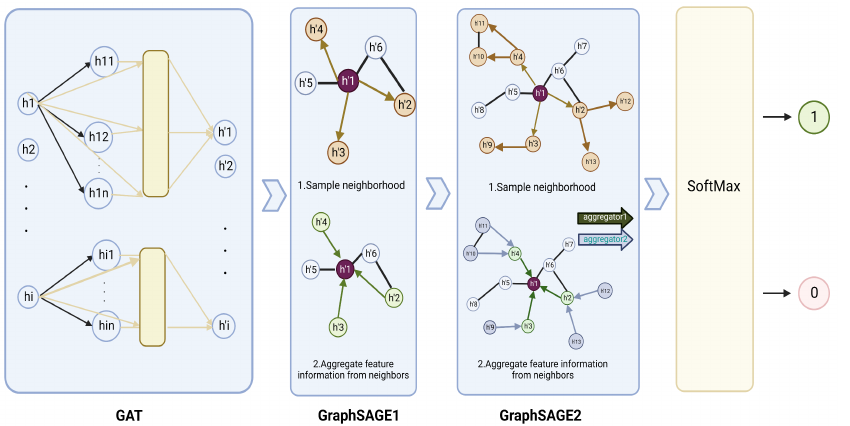
Figure 4. Graph neural network structure of GGraphSAGE framework. In the GGraphSAGE model, the feature matrix is aggregated around nodes through a GAT layer and two GraphSAGE layers for aggregating node, and each node contains the 3rd-order neighborhood information of the node. The final output is that each node (gene) is assigned a two-dimensional vector by the softmax layer, which consists of the probability that the node is a driver cancer gene and the probability that the node is a passenger gene. A label (1 or 0) is set to each node by comparing the magnitude of the two